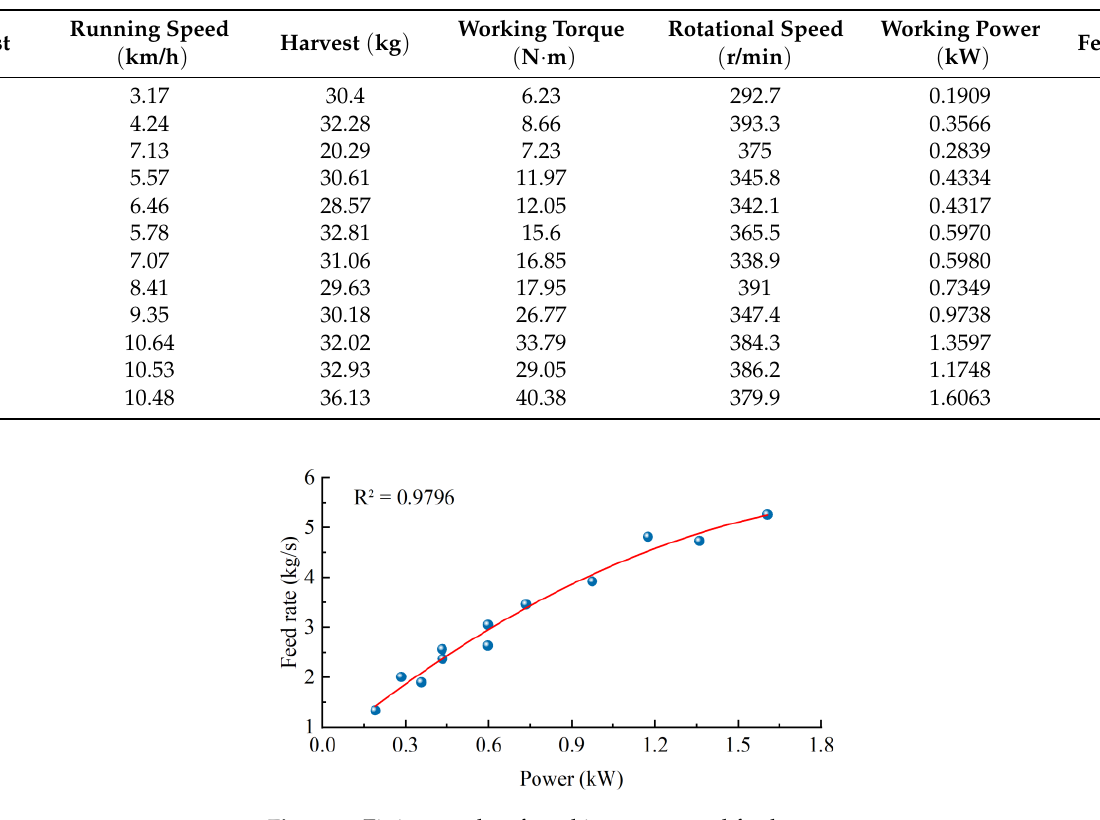
Figure 9. Fitting results of working power and feed rate.